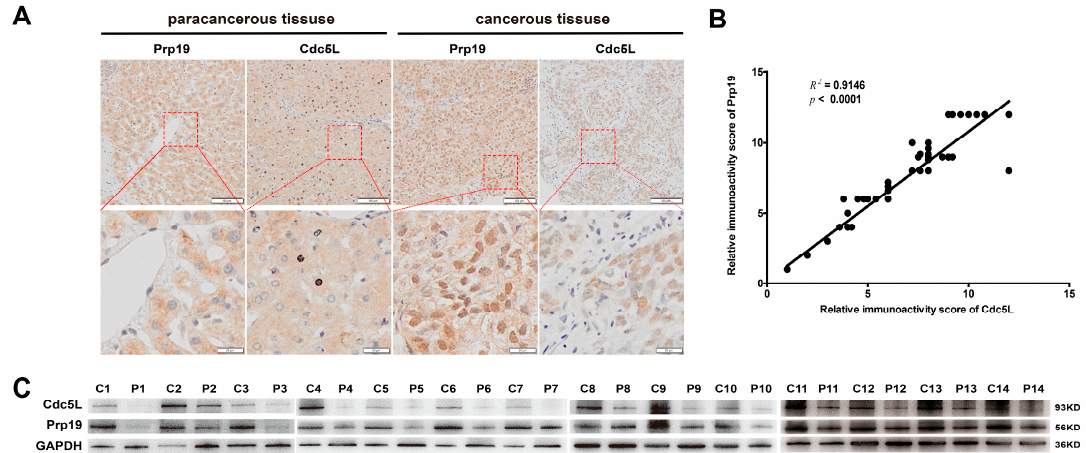
Figure 1 . The Positive Correlation of pre-mRNA processing factor 19 (Prp19) and cell division cycle 5-like (Cdc5L) in hepatocellular carcinoma (HCC). ( A ) Paracancerous and Cancerous tissue sections from HCC patients were marked with antibodies against Prp19 and Cdc5L (upper panel, scale bar = 100 μ m); Lower panel indicated the amplified view of upper panel (scale bar = 20 μ m); ( B ) The positive correlation of Prp19 and Cdc5L immunoactivity score in HCC tissues; ( C ) Prp19 and Cdc5L expression in tumor tissue (C) and paired paratumor tissue (P) from HCC patient specimens using western blot.